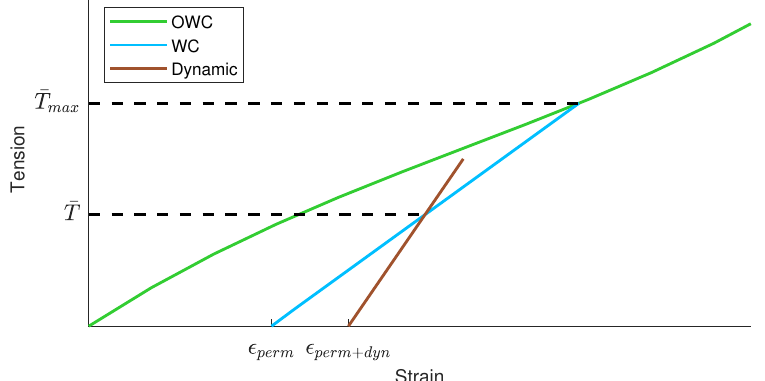
Figure 6. Updating of line lengths and stiffness using the Syrope model. (cid:101) perm denotes the permanent elongation due to historic loading, (cid:101) dyn is the additional elongation allowing the dynamic simulations to predict the correct mean elongation. Adapted from DNV RP-E305